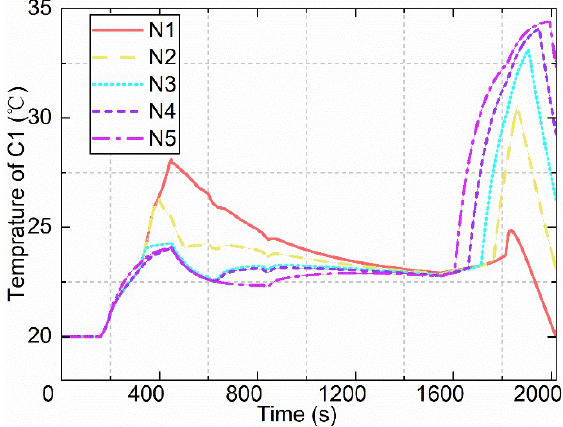
Figure 11. Temperature of different nodes in C1.